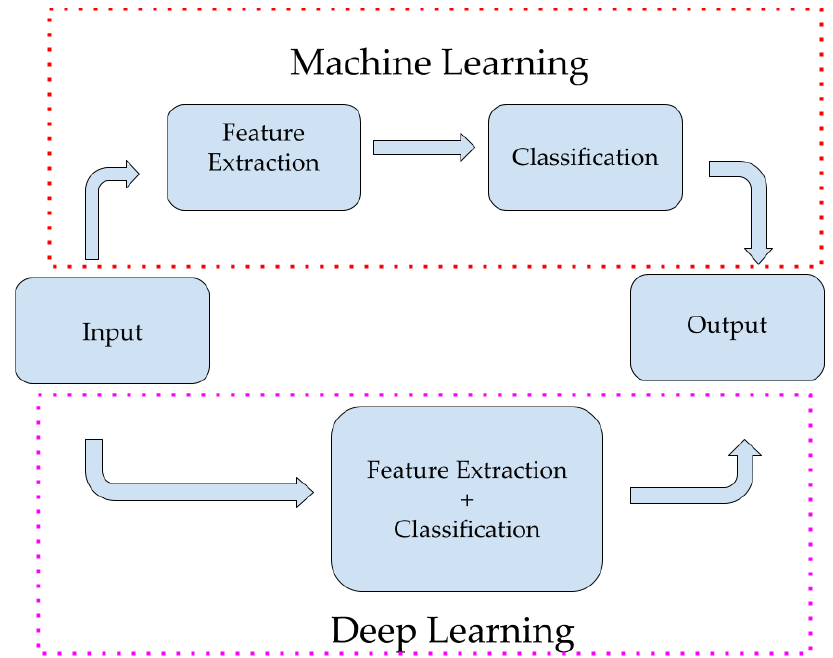
Figure 5. Sample application of machine learning and deep learning in the automotive industry and the distinction between both approaches.